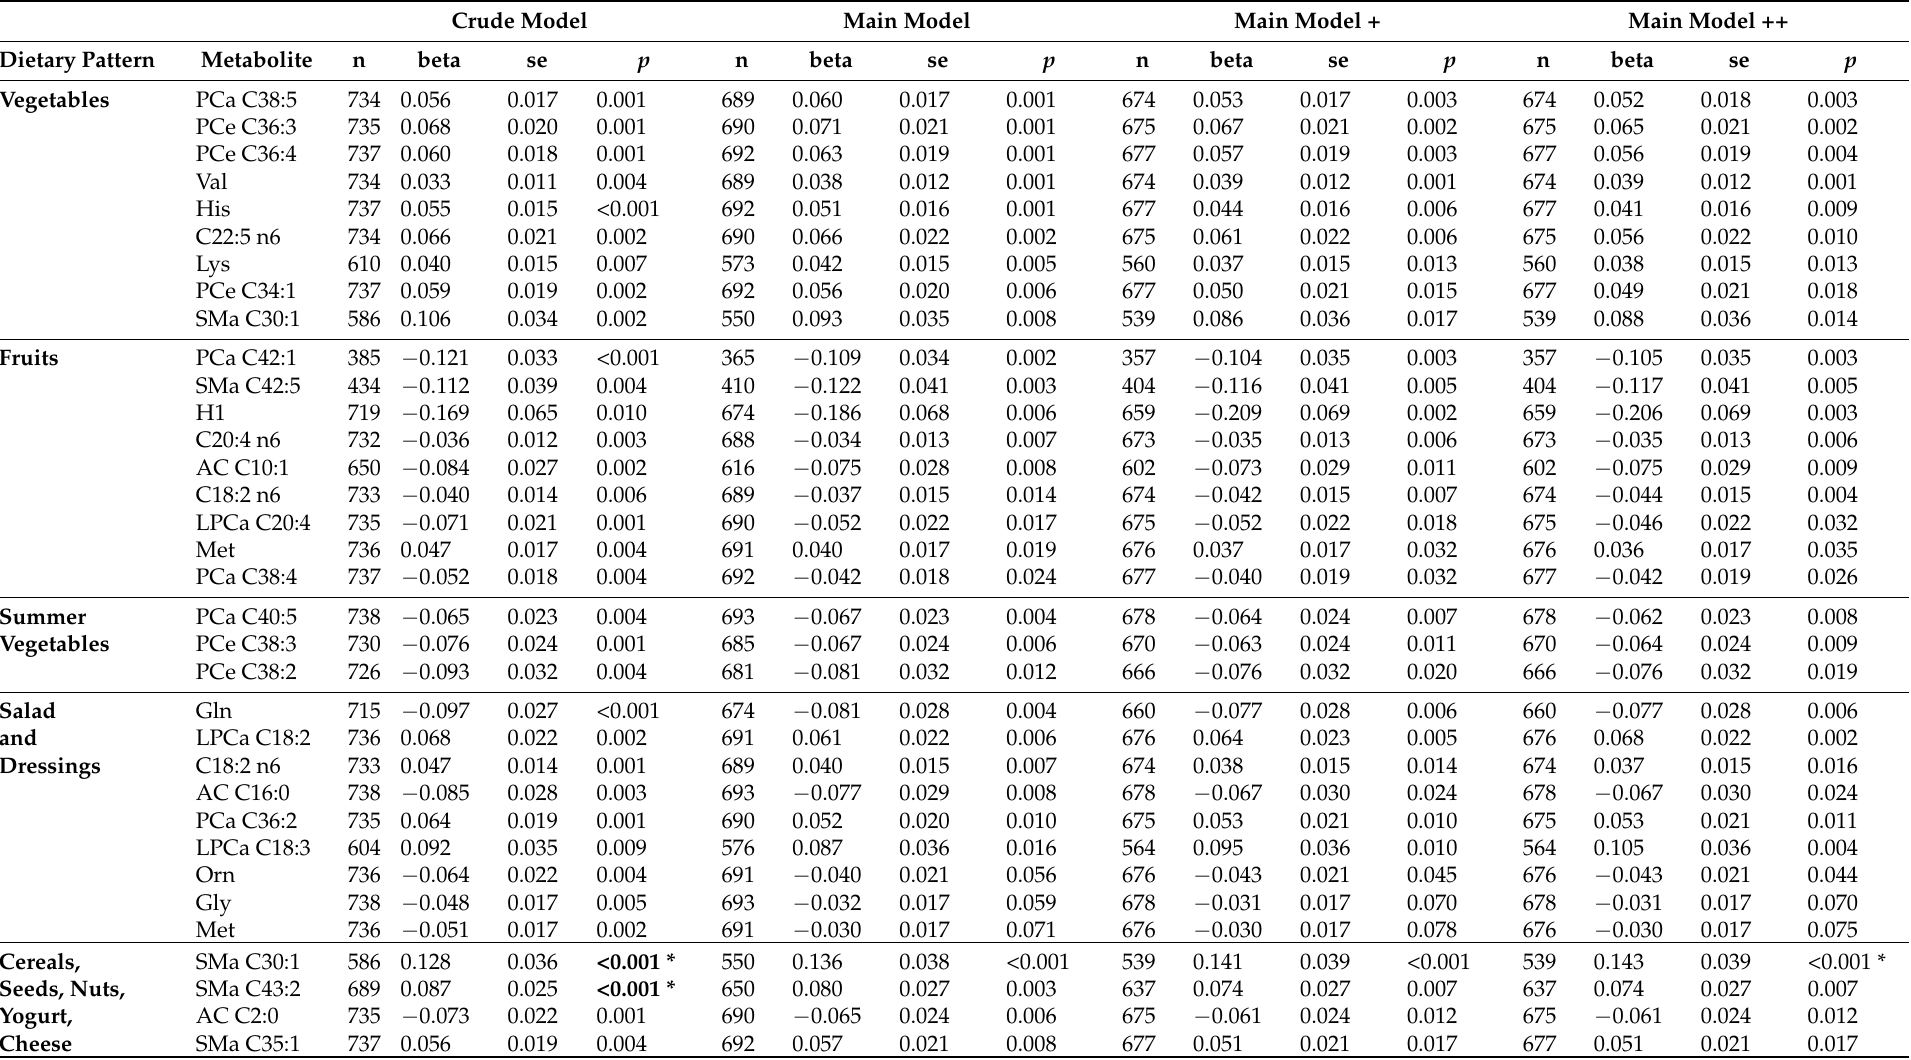
Table 3. Association of dietary patterns with cord blood